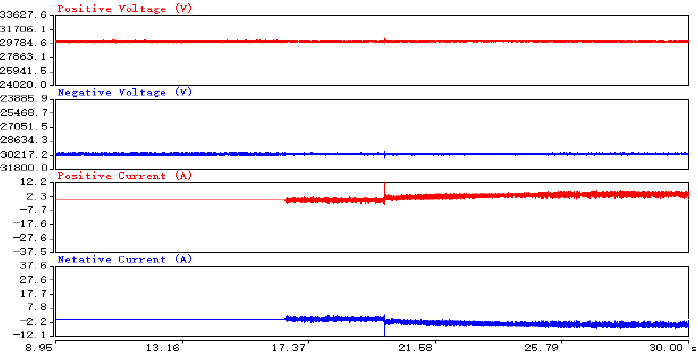
Figure 29. Startup and unlock operation waveform of the DC/DC converter.